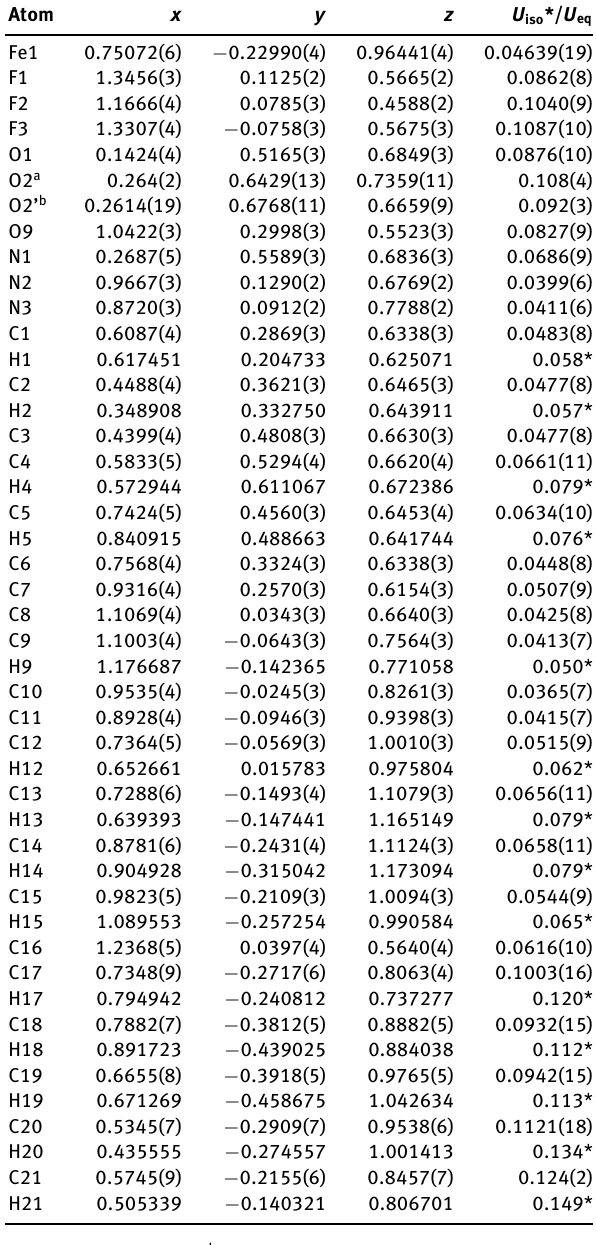
Table 2: Fractional atomic coordinates and isotropic or equivalent isotropic displacement parameters (Å 2